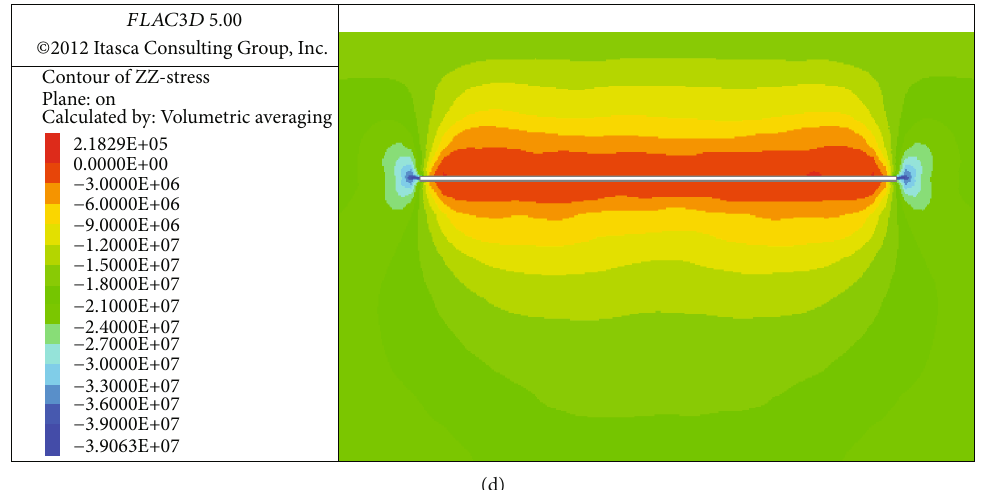
Figure 17: Vertical stress distribution of propulsion in the W coal seam as the working face is pushed to (a) 100 m, (b) 200m, (c) 300m, and (d) 400